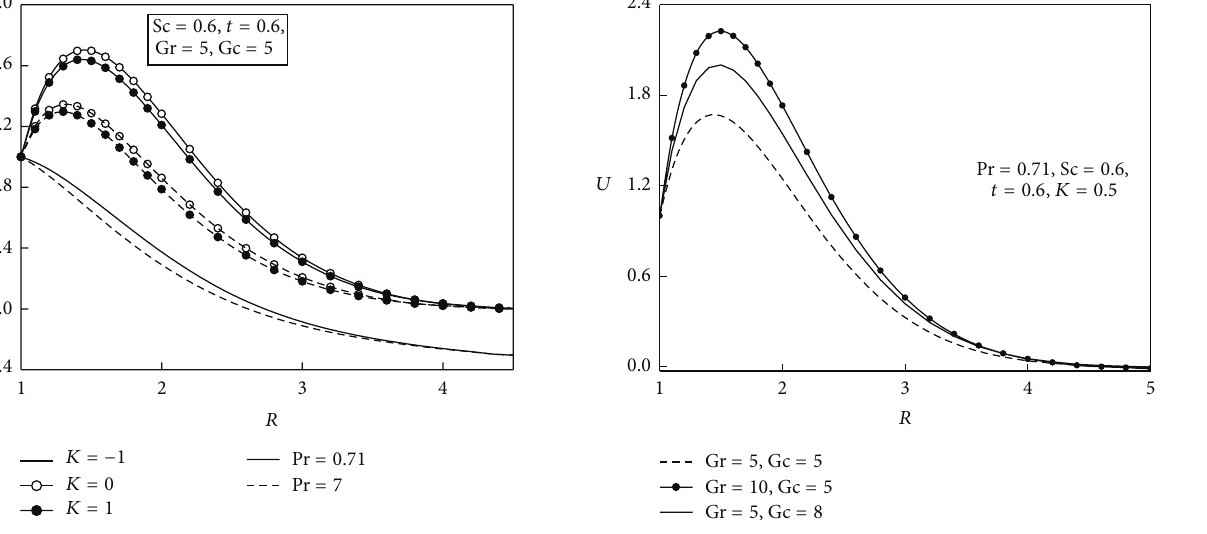
Figure 4: Effects of Gr and Gc on velocity profiles at 𝐾 = 0.5 , Sc = 0.6, 𝑡 = 0.6 , and Pr = 0.71.